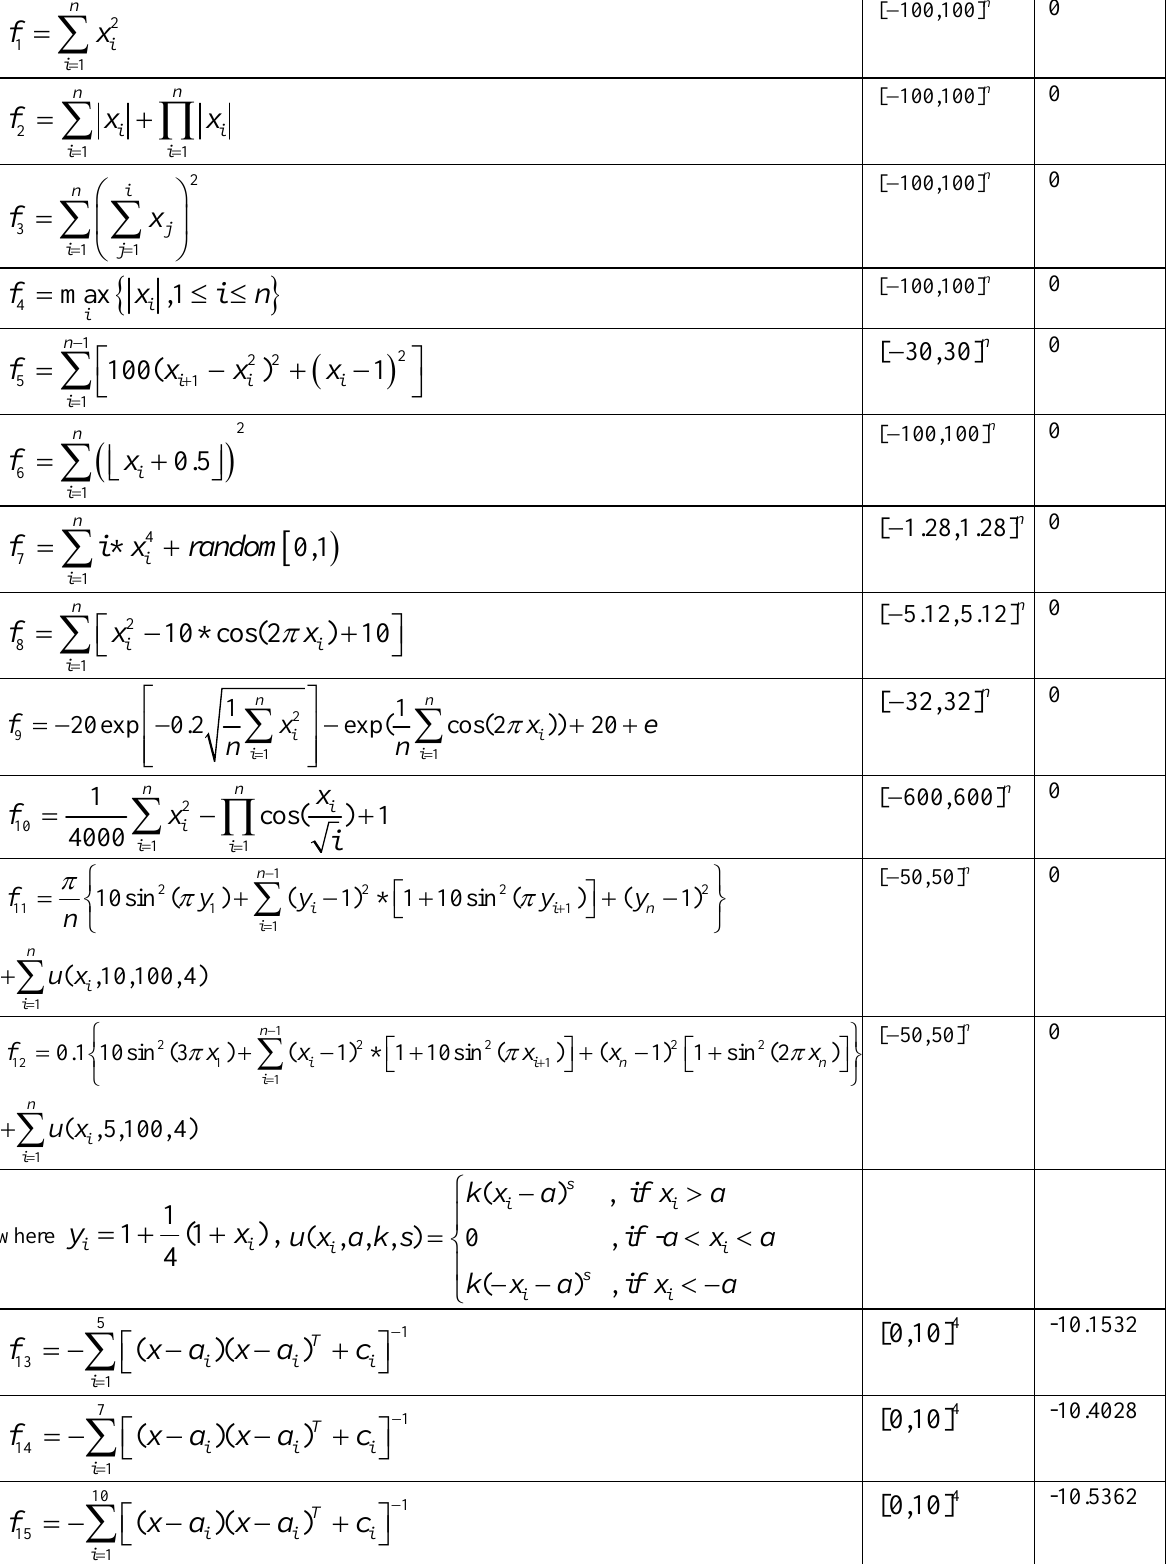
Table 1. Benchmark functions, search spaces and the known